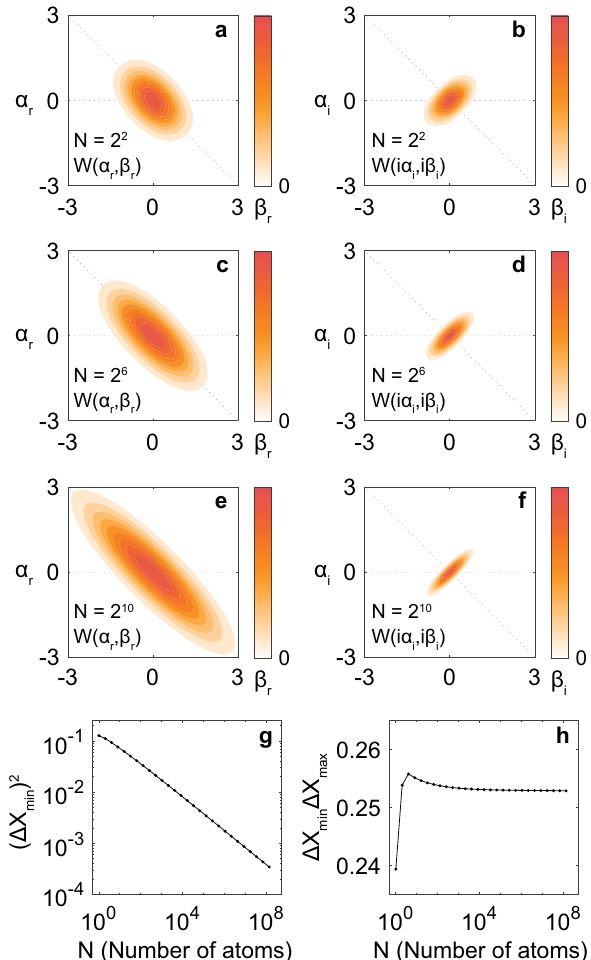
Figure 4. Wavefunctions W (α , β) and the minimum variance in the ground states of the Dicke model for ω b ω a and g 0.5 ω a . ( a, b ) N 2 6 64 , and ( e, f ) N 2 10 1024 . Panels ( g ) and ( h ) 2 2 4 , ( c, d ) N = = = = = = = = ω a and g 0.5 ω a . With the increase show (� X min ) 2 and (cid:31) X min (cid:31) X max , respectively, as functions of N for ω b = = β r and α i β i planes, respectively, along the in N , W (α , β) is getting anti-squeezed and squeezed in the α r − − 0.25 π , and (� X min ) 2 monotonically decreases as seen in Panel g. Parameters in the numerical direction of θ = − calculations are shown in “Methods”. W (α , β) is normalized to each maximum